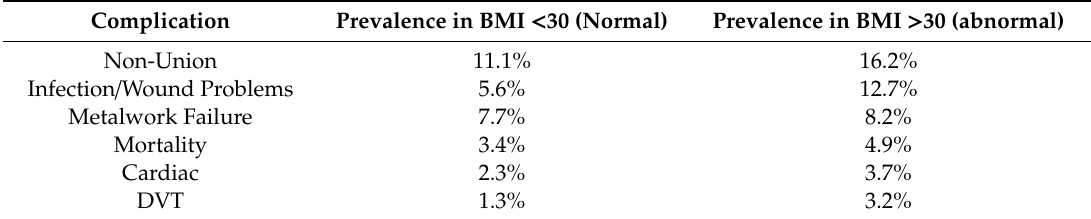
Table 2. Order of prevalence of complications (Body Mass Index (BMI)Deep Vain